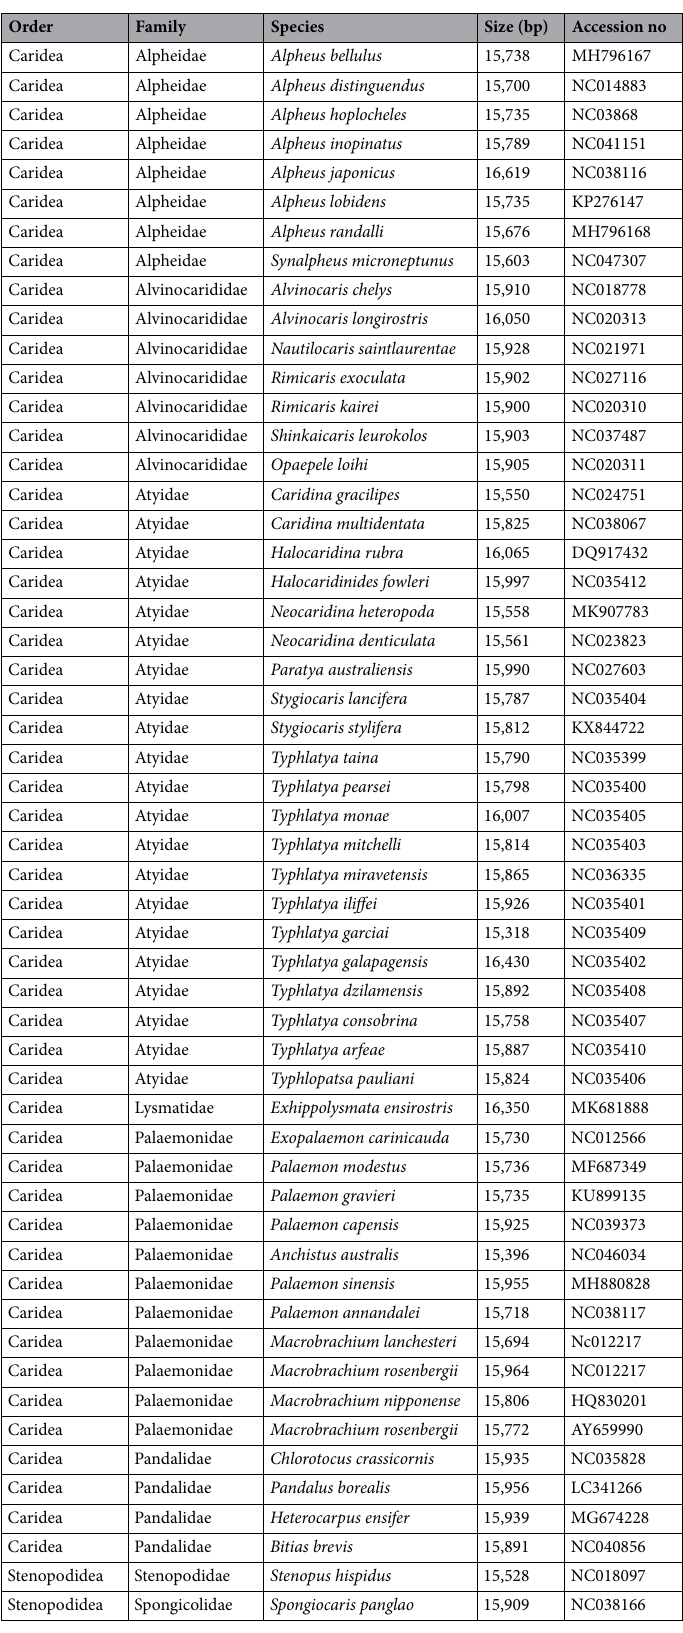
Table 4. Classification and mitochondrial genome information of families from